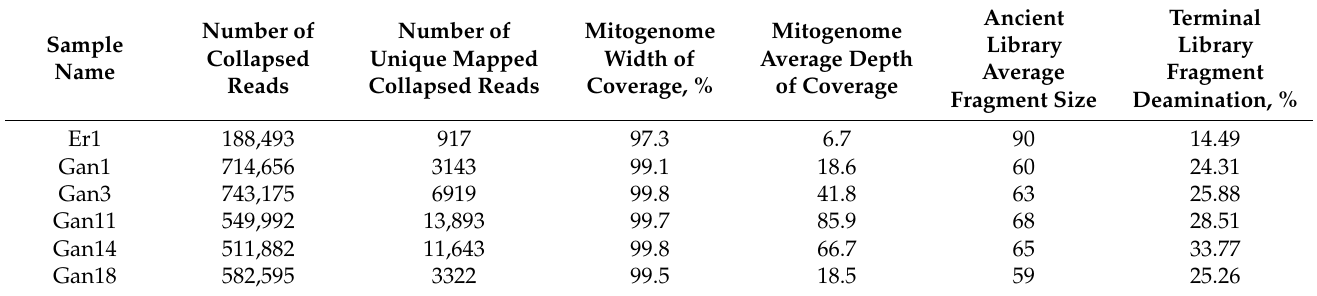
Table 1. The main characteristics of the mitochondrial genomes of the ancient horses of Mongolia.